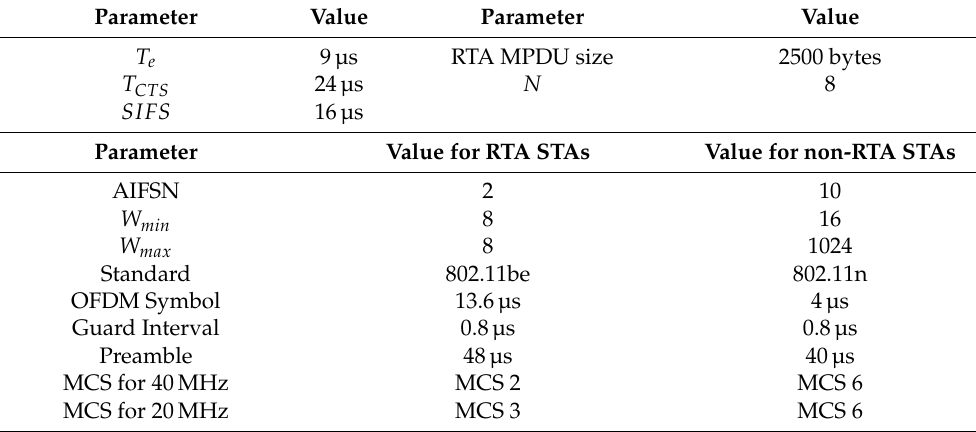
Table 2. Modeling